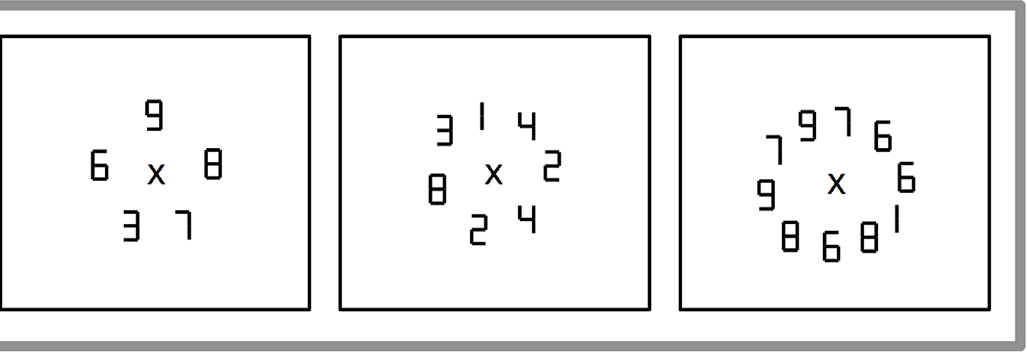
Figure 3. Example digit arrays for ensemble estimation